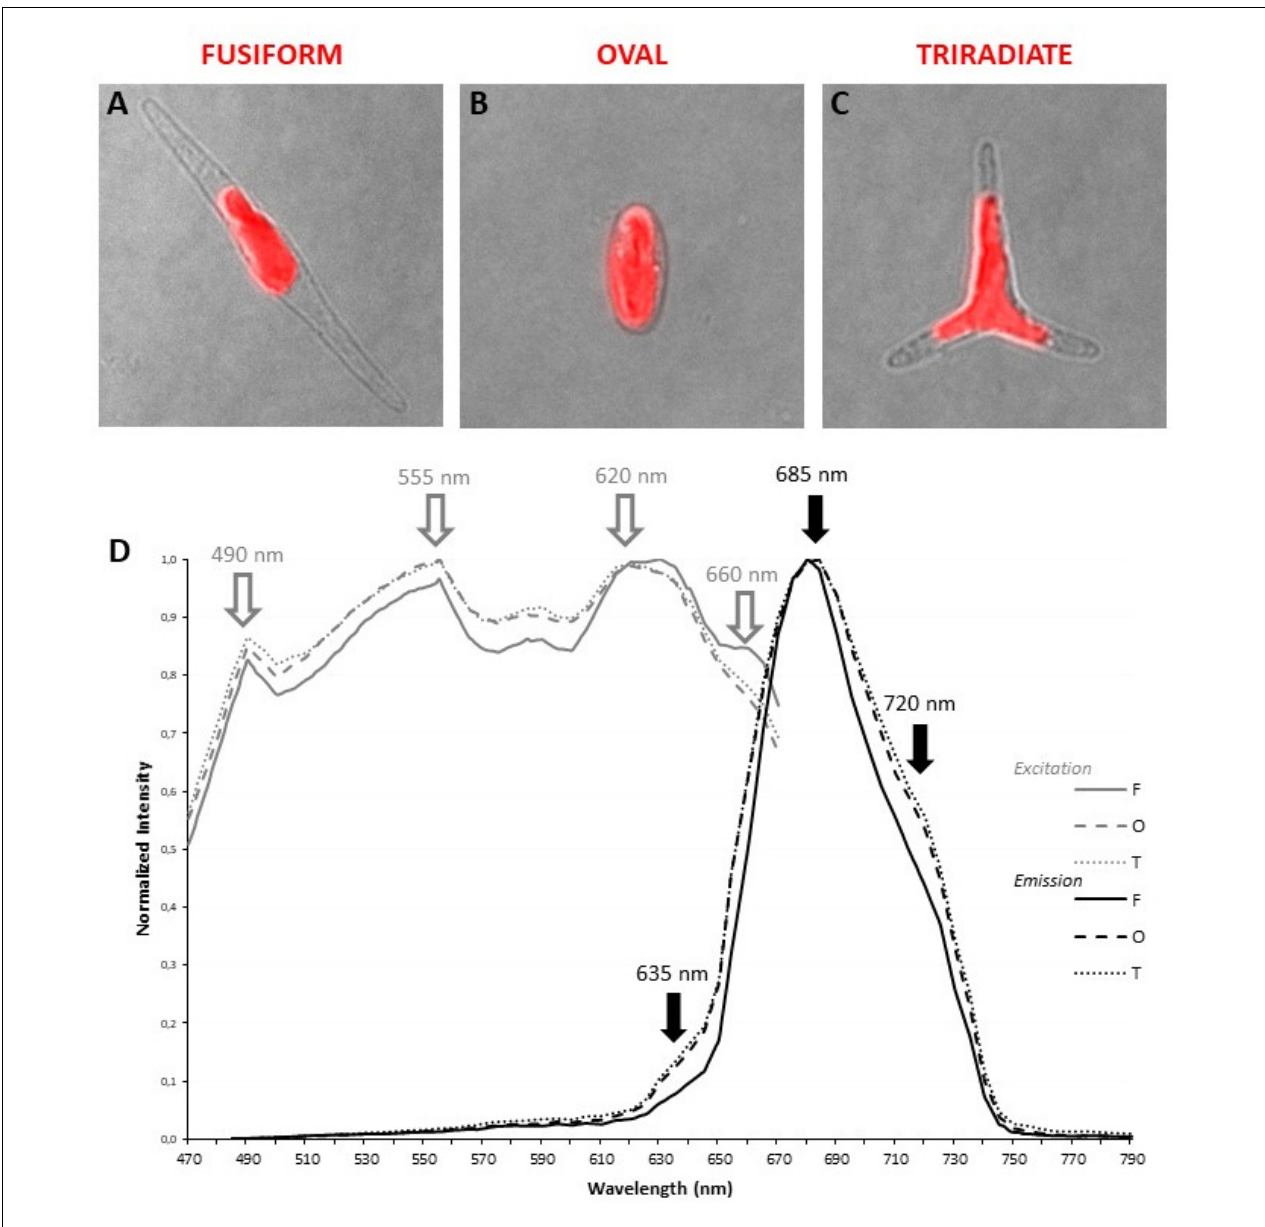
FIGURE 2 | Localization and spectral characterization of plastid autofluorescence in living P. tricornutum Pt3 morphotypes through confocal microscopy. Merged images (transmitted light and confocal microscopy) illustrating the shape and the localization of autofluorescent plastid in oval (A) , fusiform (B) , and triradiate (C) morphotype. (D) Excitation/emission spectra of plastid autofluorescence were obtained with a supercontinuum laser source through (cid:51) λ -scan microscopy ( n = 25). Excitation spectra are represented by gray lines. Emission spectra are represented by black lines. Dashed lines: oval cells; solid lines, fusiform cells; dotted lines: triradiate